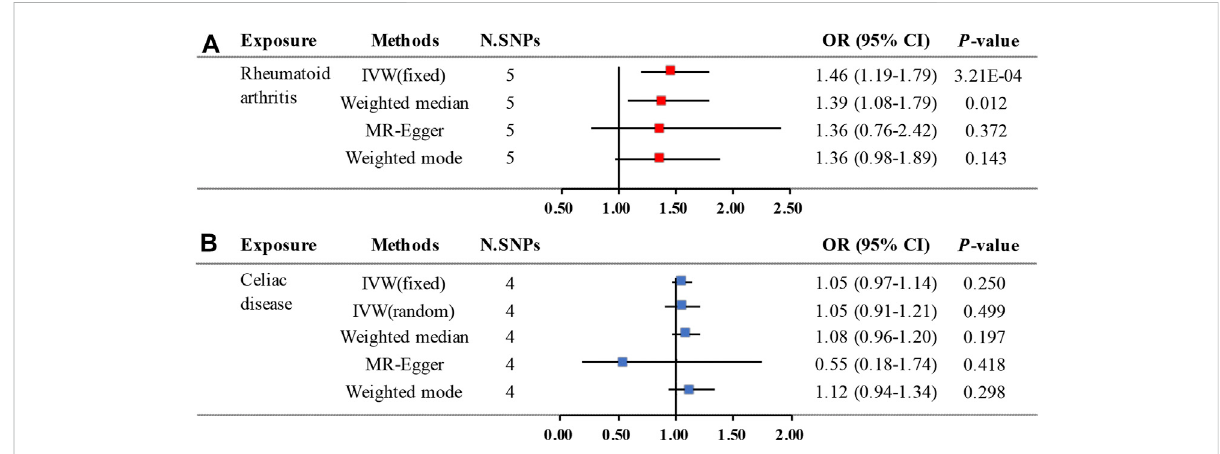
FIGURE 2 Two-sampleMRestimatesresultsofcausalassociationsbetweengeneticallypredictedRAandCD. (A) CausalestimatesresultforRAonCD. (B)